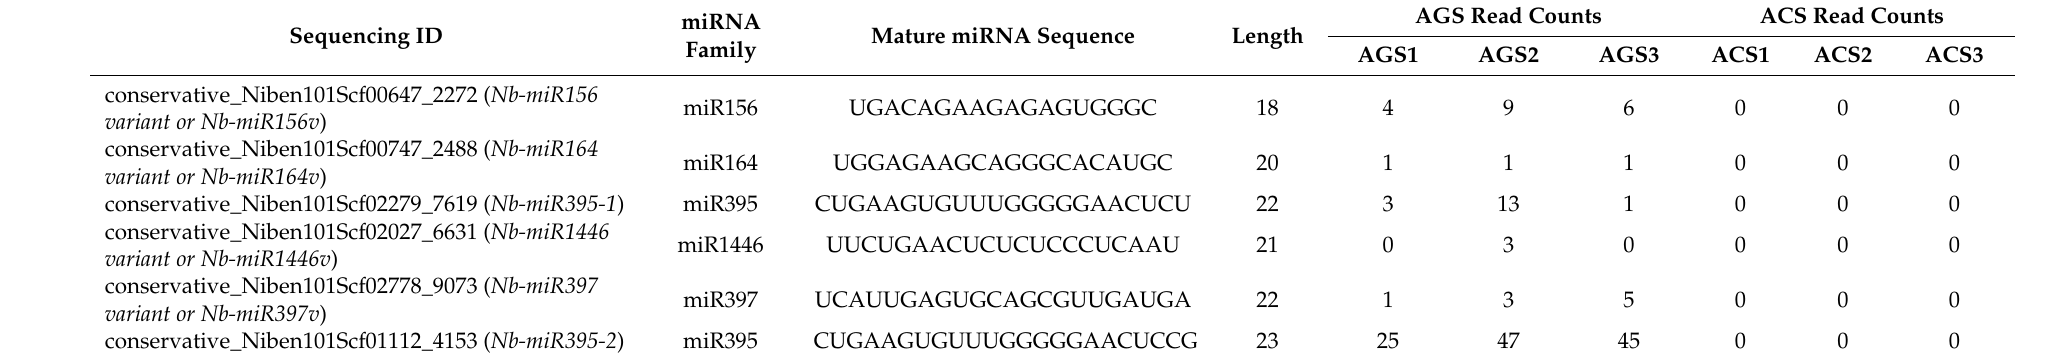
Table 3. Mobile Nb miRNAs identified from the At scion in an At/Nb